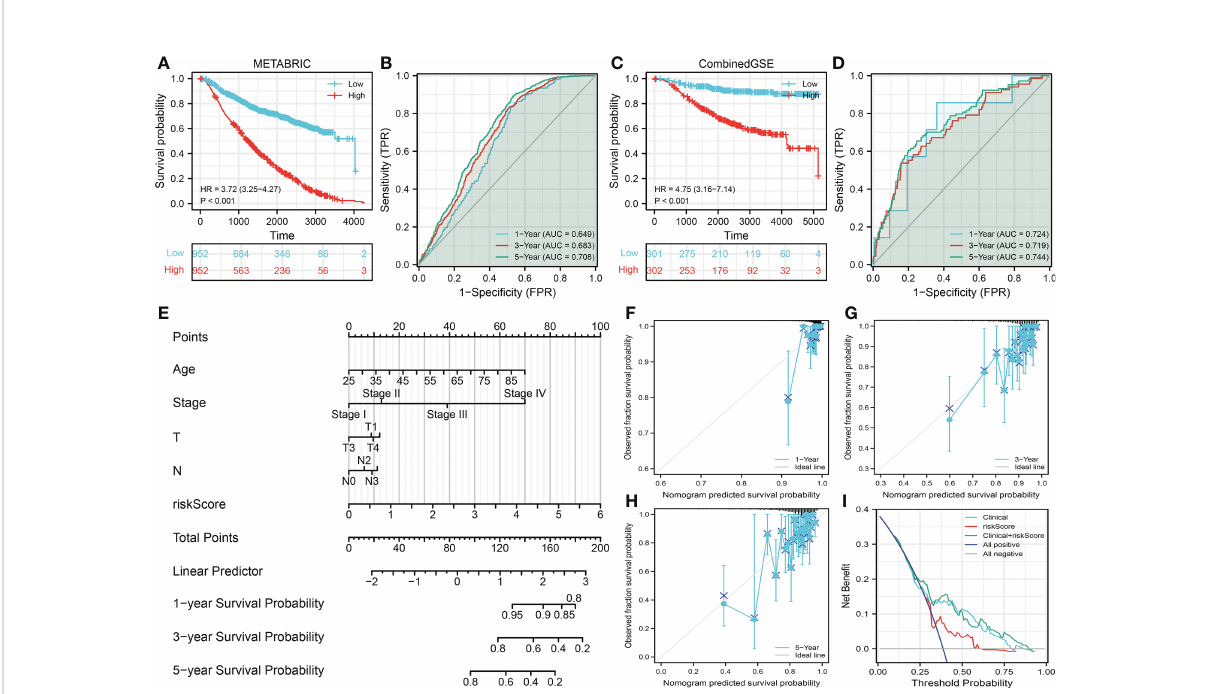
FIGURE 3 Validation of the prognosis model (A, B) Kaplan – Meier and ROC curves were performed to evaluate the prediction ef fi ciency in the METABRIC database (validation cohort). (C, D) Kaplan – Meier and ROC curves were performed to evaluate the prediction ef fi ciency in the CombinedGSE database (validation cohort). (E) A nomogram was established through combining the riskscore and clinical features for a better clinical application. (F – H) Calibration curve of 1-, 3-, and 5-year survival predicted by the nomogram. (I) Decision curve of the